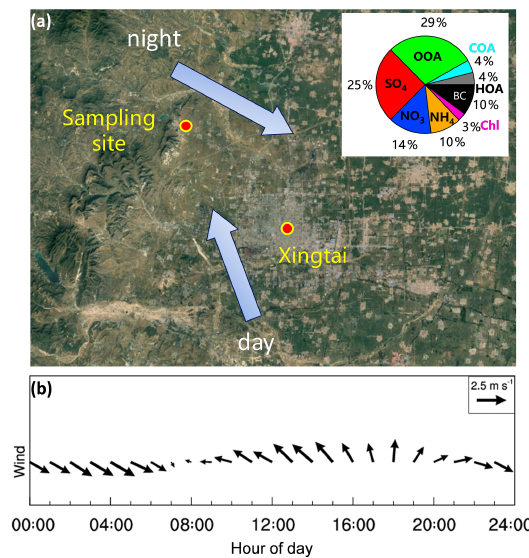
Figure 1. (a) Location of the sampling site. (b) Average diurnal evolution of wind vector. The pie chart in (a) shows the average aerosol composition for the entire study. The two arrows in (a) show the daytime and nighttime prevailing wind